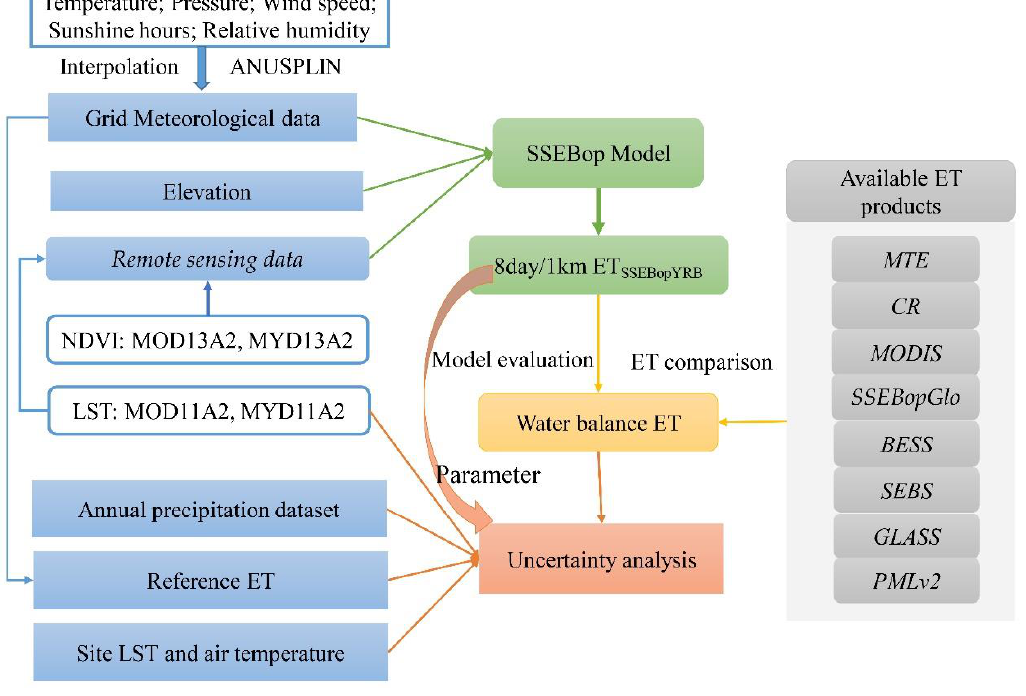
Figure 2. The framework of the assessment of ET SSEBopYRB in the YRB during the years 2003–2015.